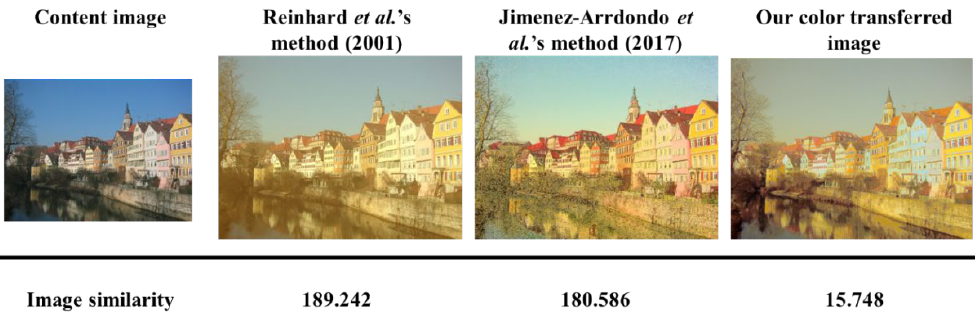
( d ) Figure 18. Comparison with Gatys et al.’s method. ( a ) Content image. ( b ) Target image. ( c ) Our results. ( d ) The result of Gatys et al.’s method, with the content features on layer conv4_2 and the style features on layer conv1_1, conv2_1, conv3_1, conv4_1, and conv5_1.